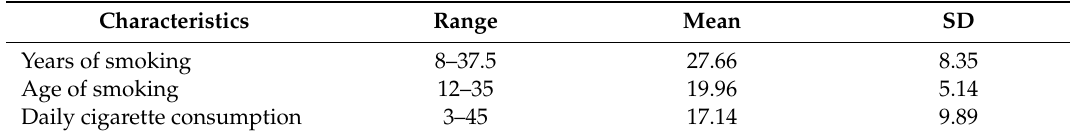
Table 2. Characteristics of the participants’ smoking behaviors (N =